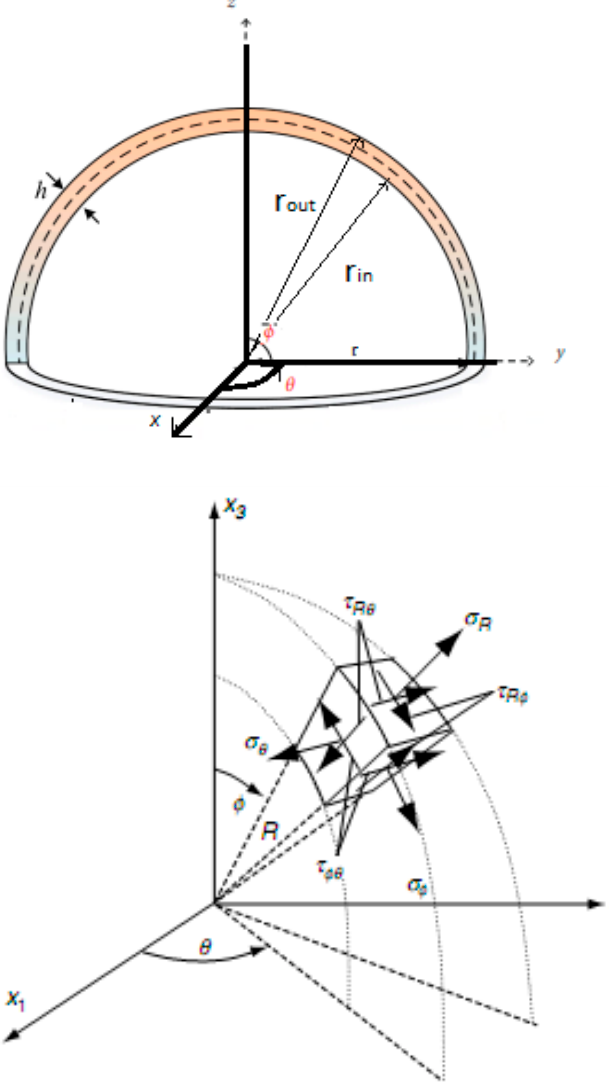
Figure 1. Main geometric parameters and assumptions for the spherical cap.